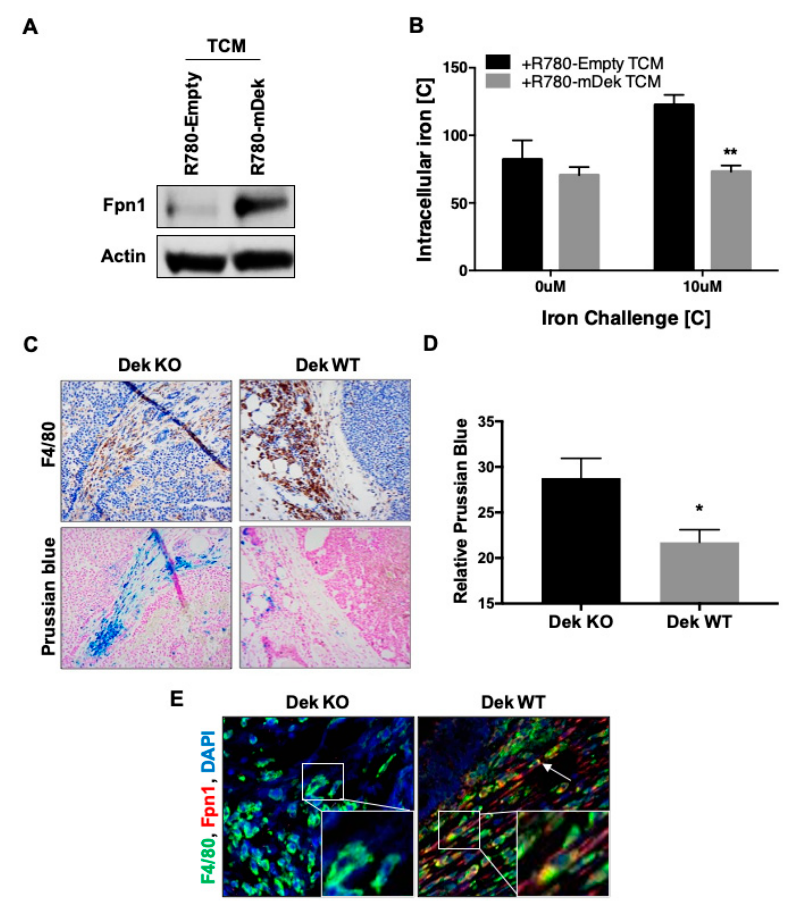
Figure 4. Macrophages exposed to Dek expressing cancer cells exhibit an M2-like iron recycling phenotype. ( A ) Ferroportin 1 (FPN1) iron transporter protein expression is upregulated in macrophages cultured in R780-mDek TCM compared to macrophages cultured in R780-Empty TCM. ( B ) BMDM exposed to TCM from RD147 Dek expressing cancer cells (R780-mDek TCM) retained less iron with the addition of 10 uM iron challenge compared to BMDM cultured in TCM from Dek-deficient R780-Empty cells, n = 3. ( C ) Immunohistochemistry was performed on adjacent sections of mammary tumor tissue from Dek KO (left) and WT (right) mice for a pan macrophage marker, F4/80, (top) and Perls Prussian Blue, a stain for ferric iron retained within cells (bottom). ( D ) Quantification of Prussian blue staining in Dek WT tumors was significantly less than seen in Dek KO tumors, as determined by ImageJ analysis, n = 3 per genotype. ( E ) Immunofluorescence was performed on Dek KO (left) and WT (right) murine mammary tumors for F4/80 (green) and Fpn1 (red) and DAPI (blue). White arrows in the Dek WT tumor indicated the co-localization of F4/80 and Fpn1. * indicates p -value is <0.05 and ** indicates p -value is < 0.01 using Student’s t -test.